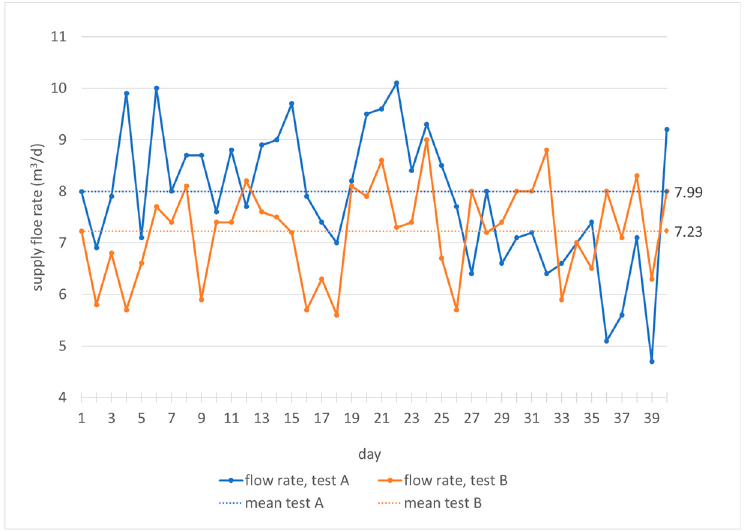
Figure 3. Monitoring of feeding biomass flow rate in the digesters during the hydraulic retention time.